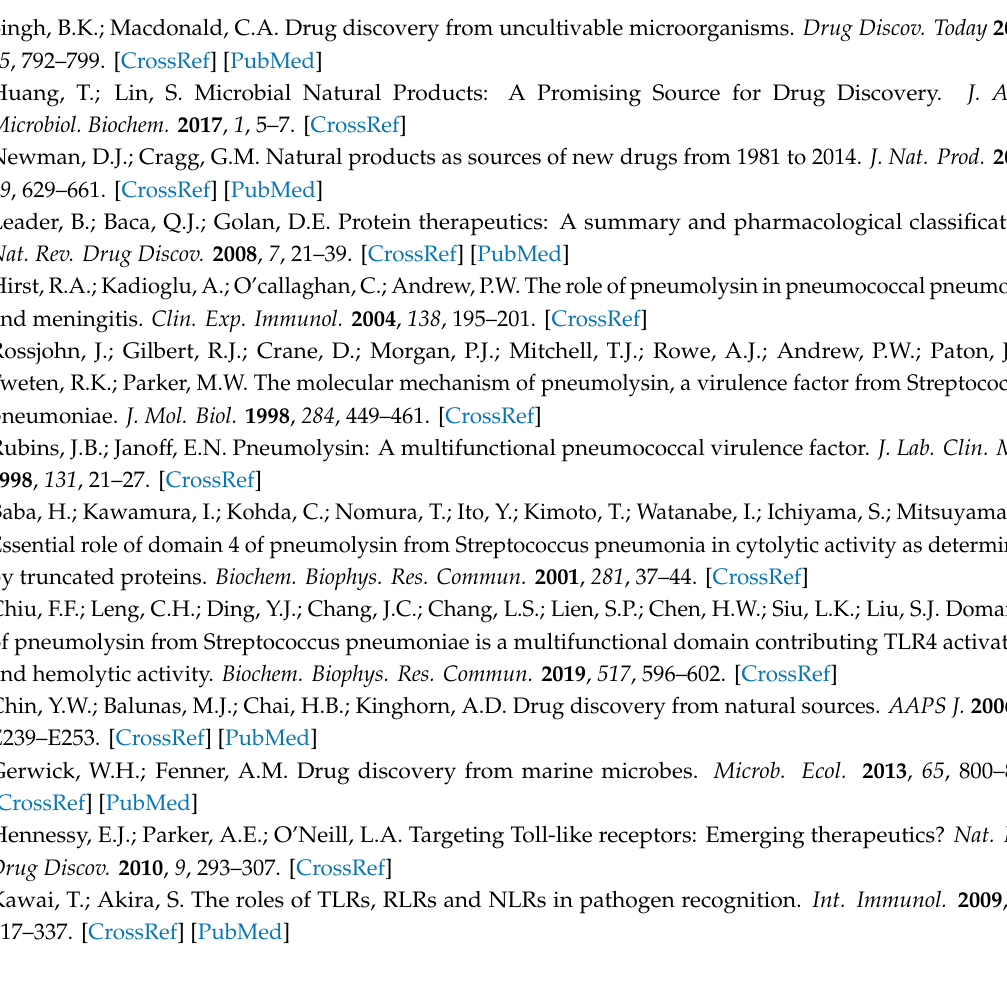
Figure S1: Gel images of Western blot in Figure